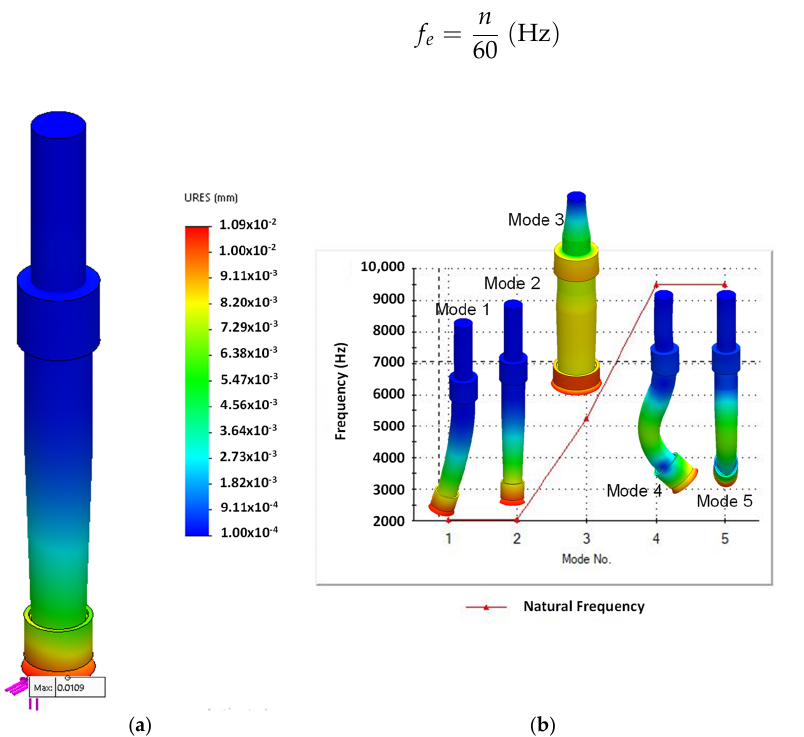
Figure 3. Static and dynamic deformation of the rotary tool holder: ( a ) deflection; ( b ) natural fre- quency.